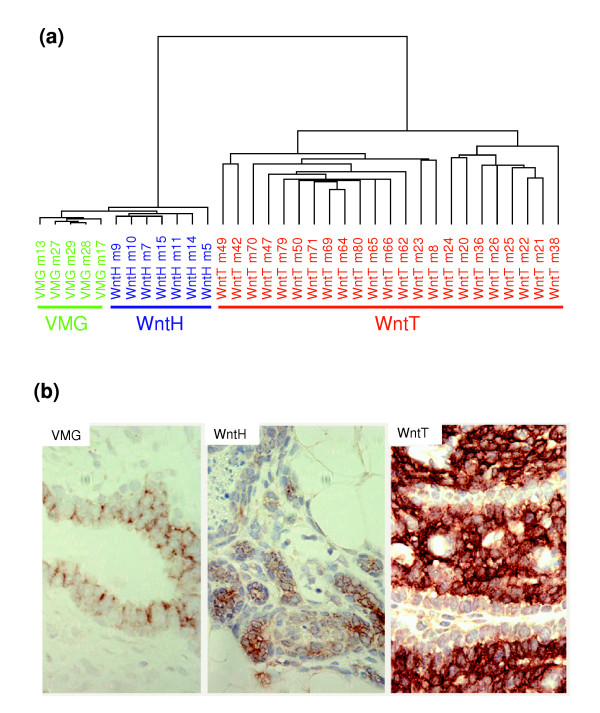
Gene expression in mammary tumor evolution in MMTV-Wnt-1 transgenic mice. (a) Dendrogram of 35 samples analyzed by average linkage hierarchical clustering analysis, using 3,359 genes selected for high variability across all samples. 15k arrays were used. (b) Immunohistochemical staining for c-Kit in the indicated tissue sections. A 20× objective was used. MMTV, mouse mammary tumor virus; VMG, virgin mammary glands from nontransgenic mice; WntT, mammary tumors from MMTV-Wnt-1 transgenic mice; WntH, hyperplastic mammary glands from MMTV-Wnt-1 transgenic mice.